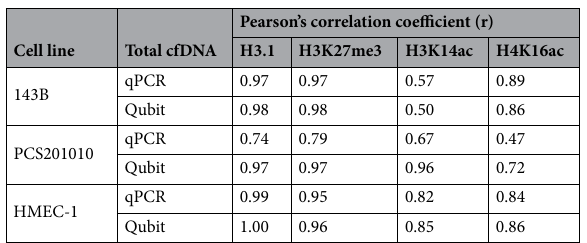
Table 1. Correlation between changes in total cfDNA levels vs. total cell-free nucleosomal H3.1, H3K27me3, H3K14ac, and H4K16ac levels, respectively, over increasing incubation periods in three cell lines.